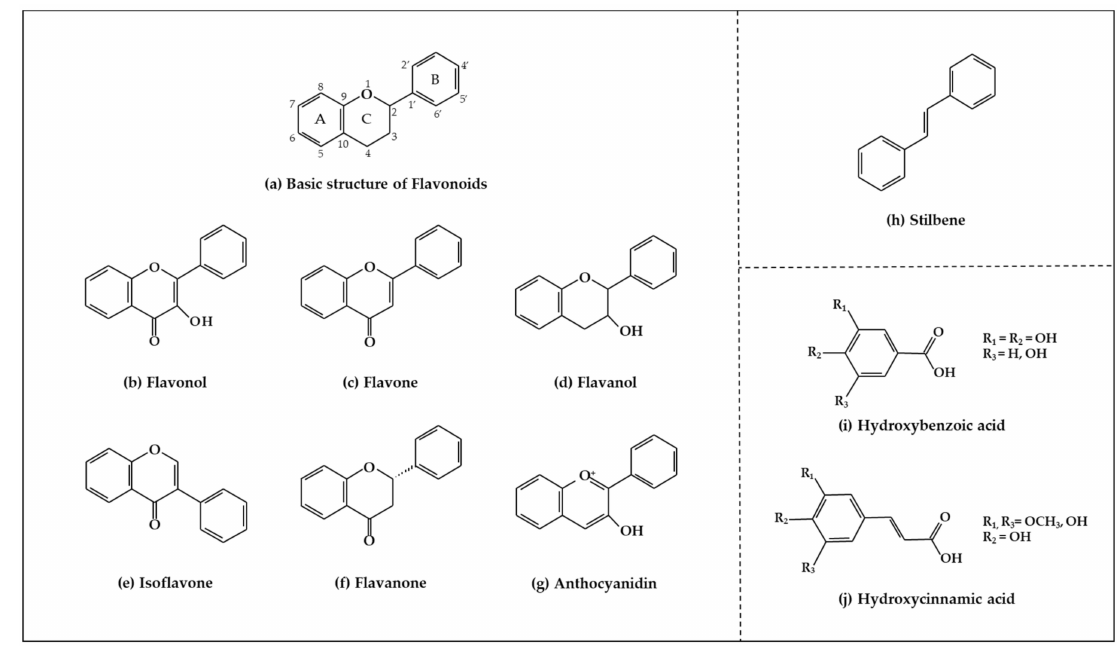
Figure 1. Structure of phenolic